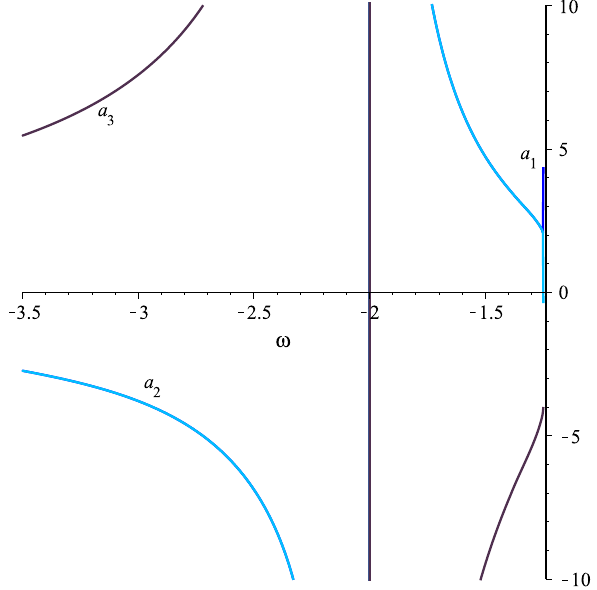
Fig. 2 Real parts of the eigenvalues corresponding to P 2 − . The curves corresponding to a 1 and a 2 are not superposed only near ω = − 1 . 25, and they show a divergence for ω = − 2